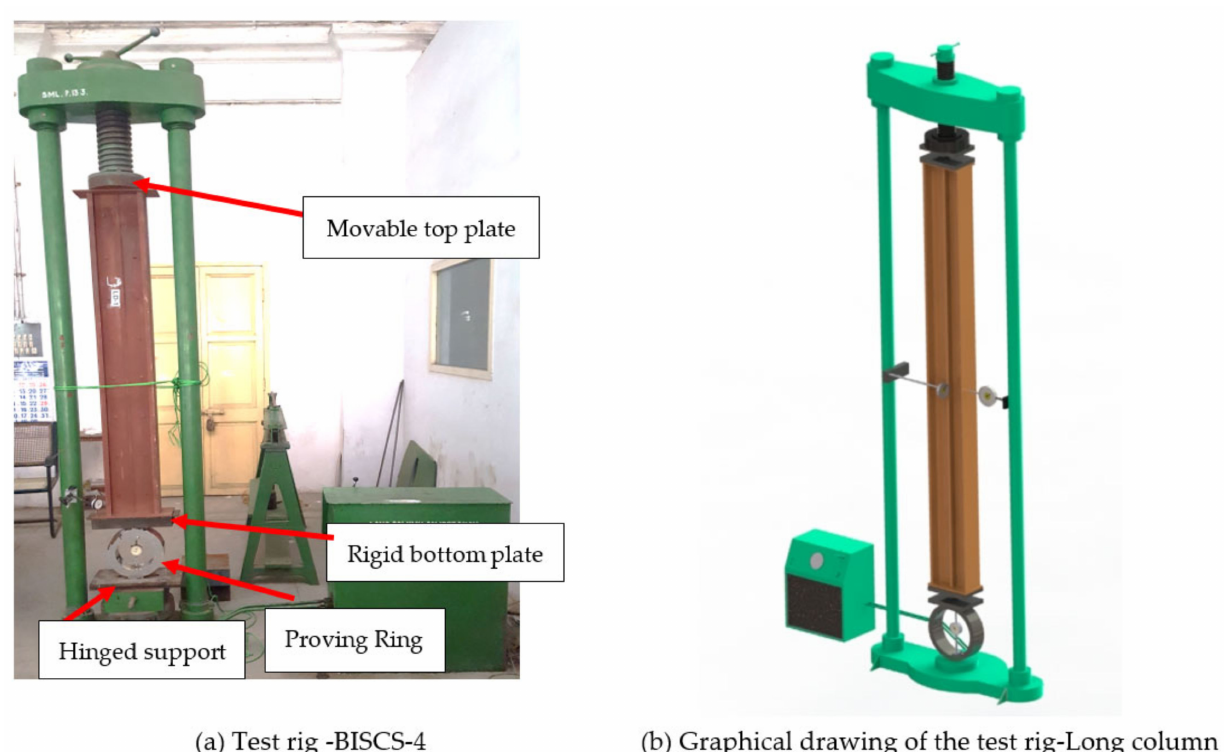
Figure 8. An image of the experimental test